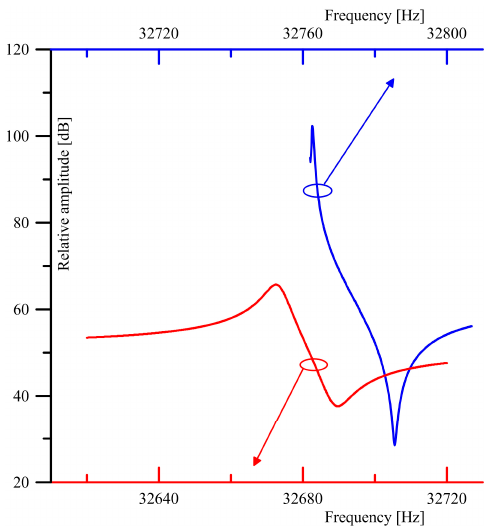
Figure 6. QTF admittance vs. frequency measured with a frequency step of 0.1 Hz before (upper plot) and after (bottom plot) of the QTF package cup removal (32.768 kHz crystal resonator, model LFXTAL002996Bulk, manufactured by IQD Frequency Products).